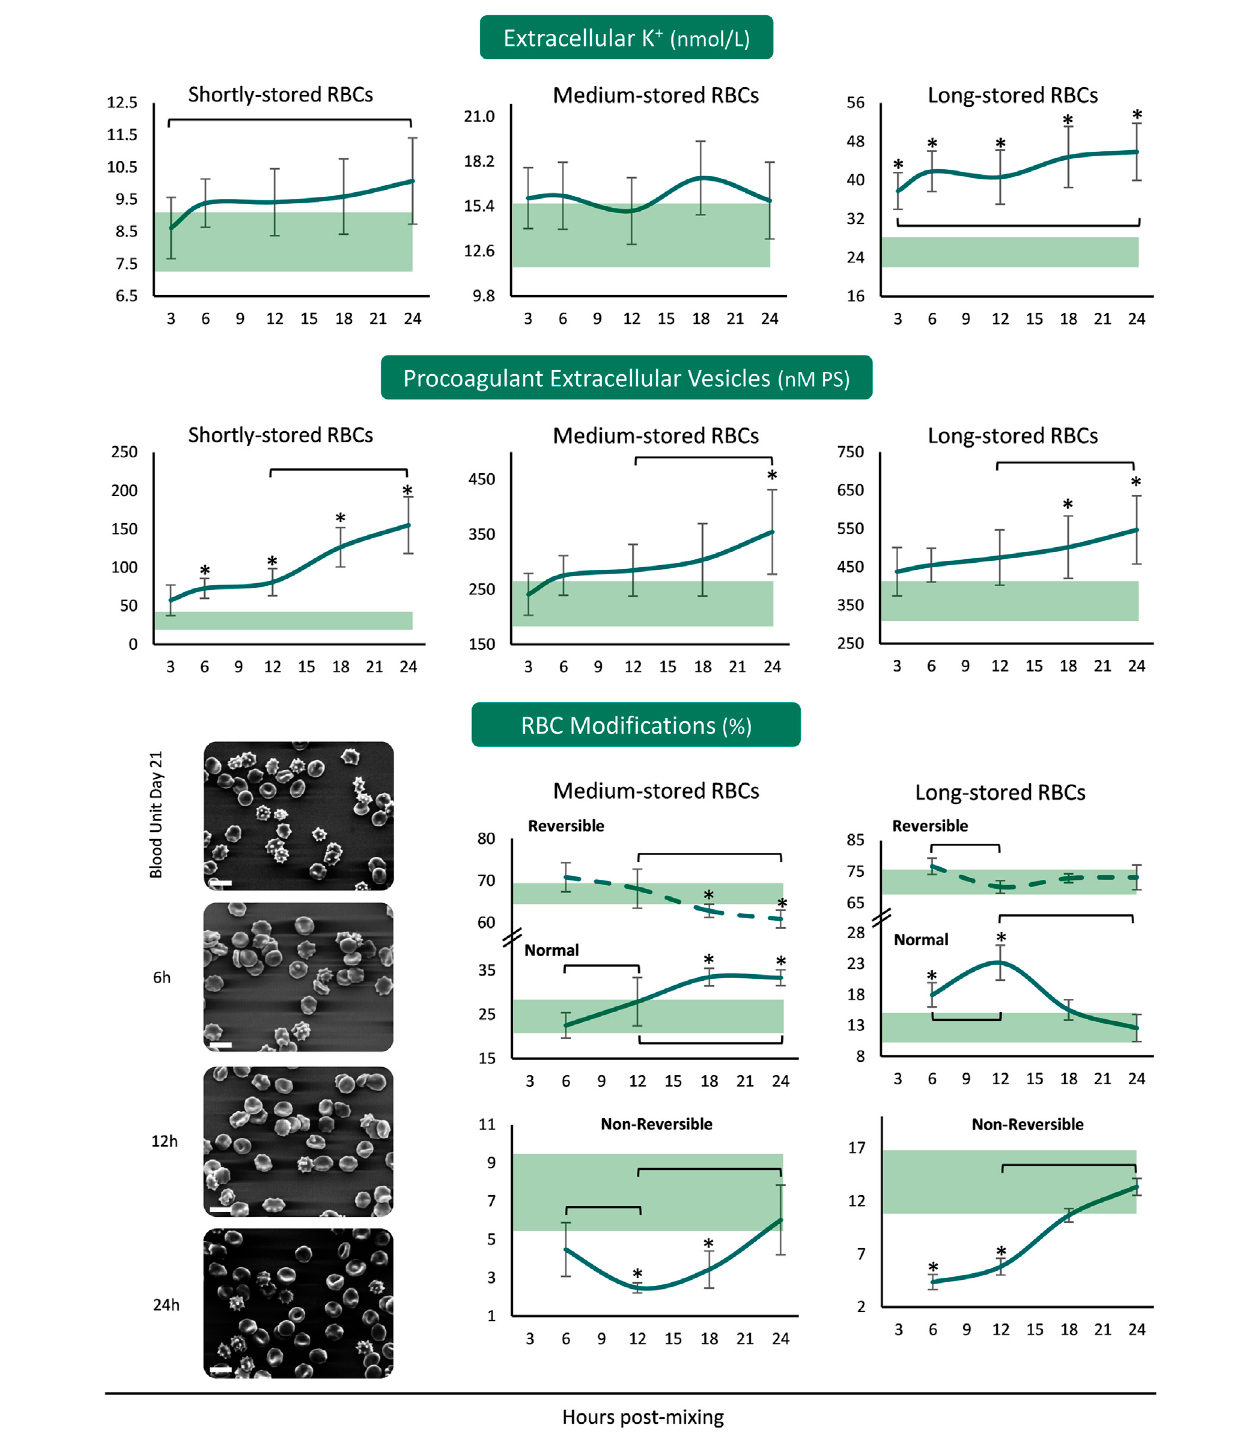
FIGURE 3 | Potassium leakage, extracellular vesicles ’ procoagulant activity and RBC morphology of reconstituted stored red blood cells in freshly drawn plasma. Baseline levelsofstoredRBCsinthecold(4 ° C)areshownbytransparent horizontal bands(bandthicknessisrepresentative ofthestandarddeviation[SD]).(*) p < 0.050 reconstituted RBCs vs. baseline RBCs in the cold; brackets show differences with p < 0.050 between 3 h (or 6 h in the case of RBC modi fi cations), 12 and 24 h post reconstitution. Representative micrographs from scanning electron microscopy are shown for day 21 samples (x 1,000); white scale bars: 10 μ m.